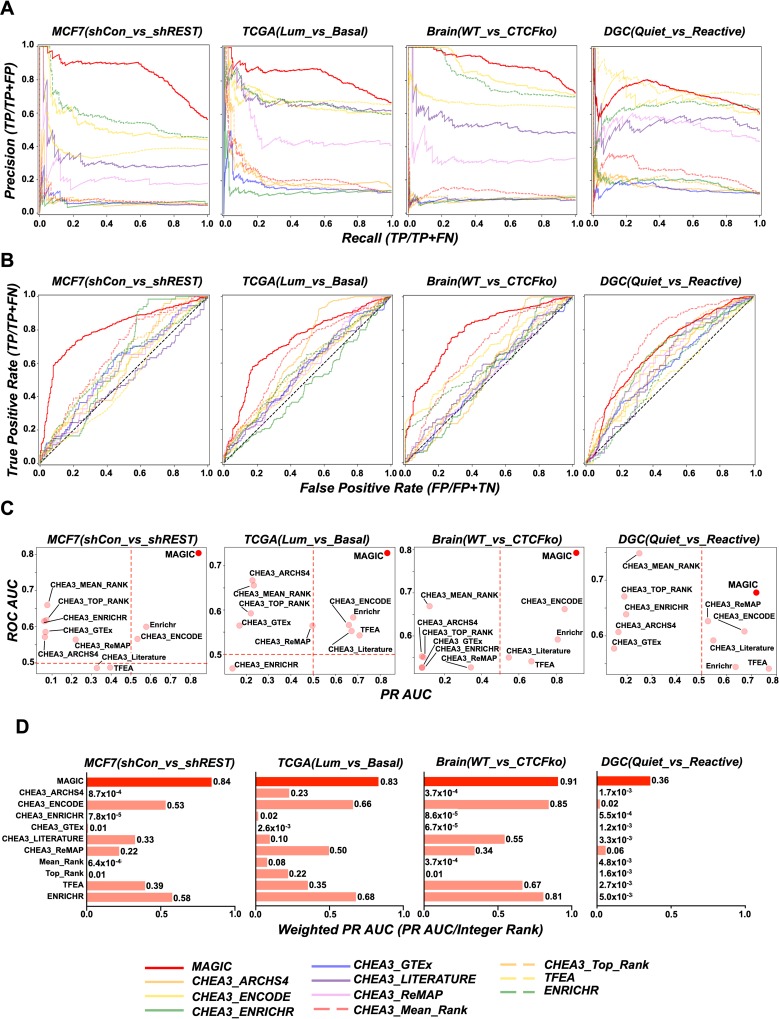
MAGIC demonstrates skill at calling manipulated factors as assessed by Precision Recall and Receiver Operator Characteristics.(A) Precision Recall curves for the four datasets and all algorithms and libraries. (B) Receiver Operator Characteristic curves for the four datasets and all algorithms and libraries. As in panel A, data was not balanced prior to graphing. (C) ROC versus PR AUCs for all algorithms and libraries. (D) PR AUCs were scaled for fractional rank of the manipulated factor by multiplying PR UAC by FR.